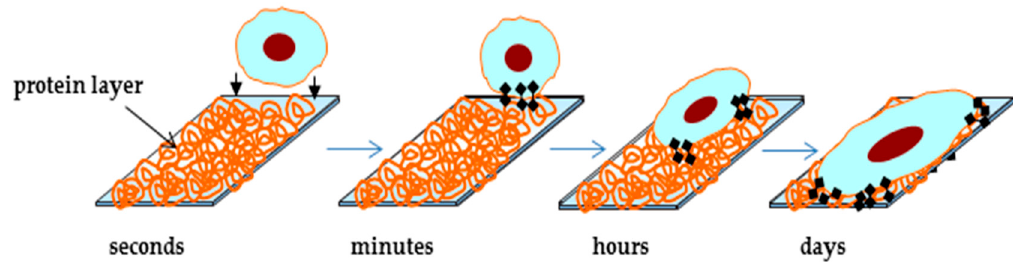
Figure 1. Kinetics and phases of cell adhesion.